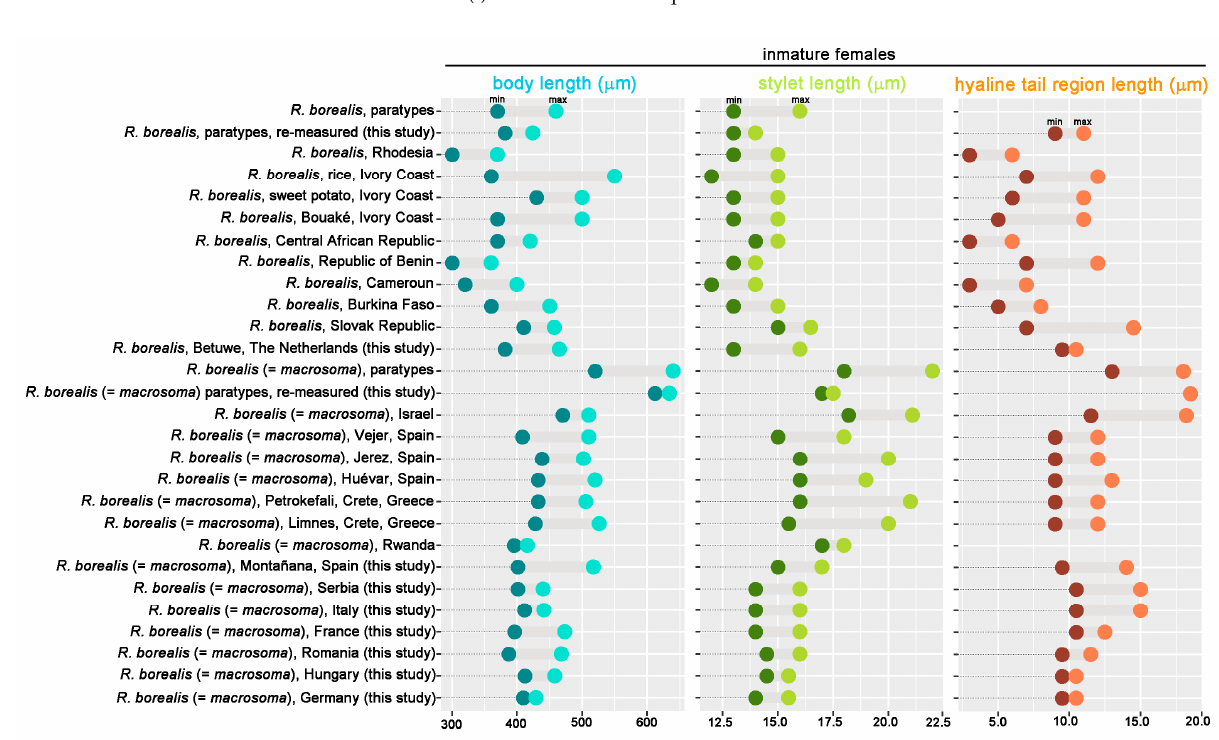
Figure 2. Range (minimum and maximum) comparative key diagnostic measures of immature females (body, stylet, and hyaline female tail lengths) for separating among R. borealis and R. macrosoma populations in decreasing chronological order of publication.